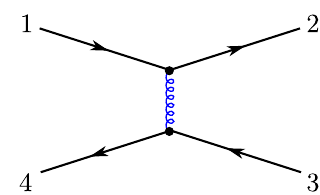
Figure 7 . We depict the exchange of a N = 2 Yang-Mills multiplet as a wavy line; the straight, directed lines are hypermultiplet